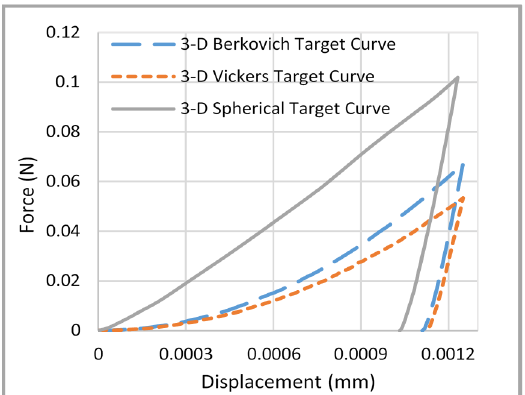
Figure 3. Target numerical load displacement curves determined from 3-D simulations for Berkovich indentation, Vickers indentation and spherical indentation.